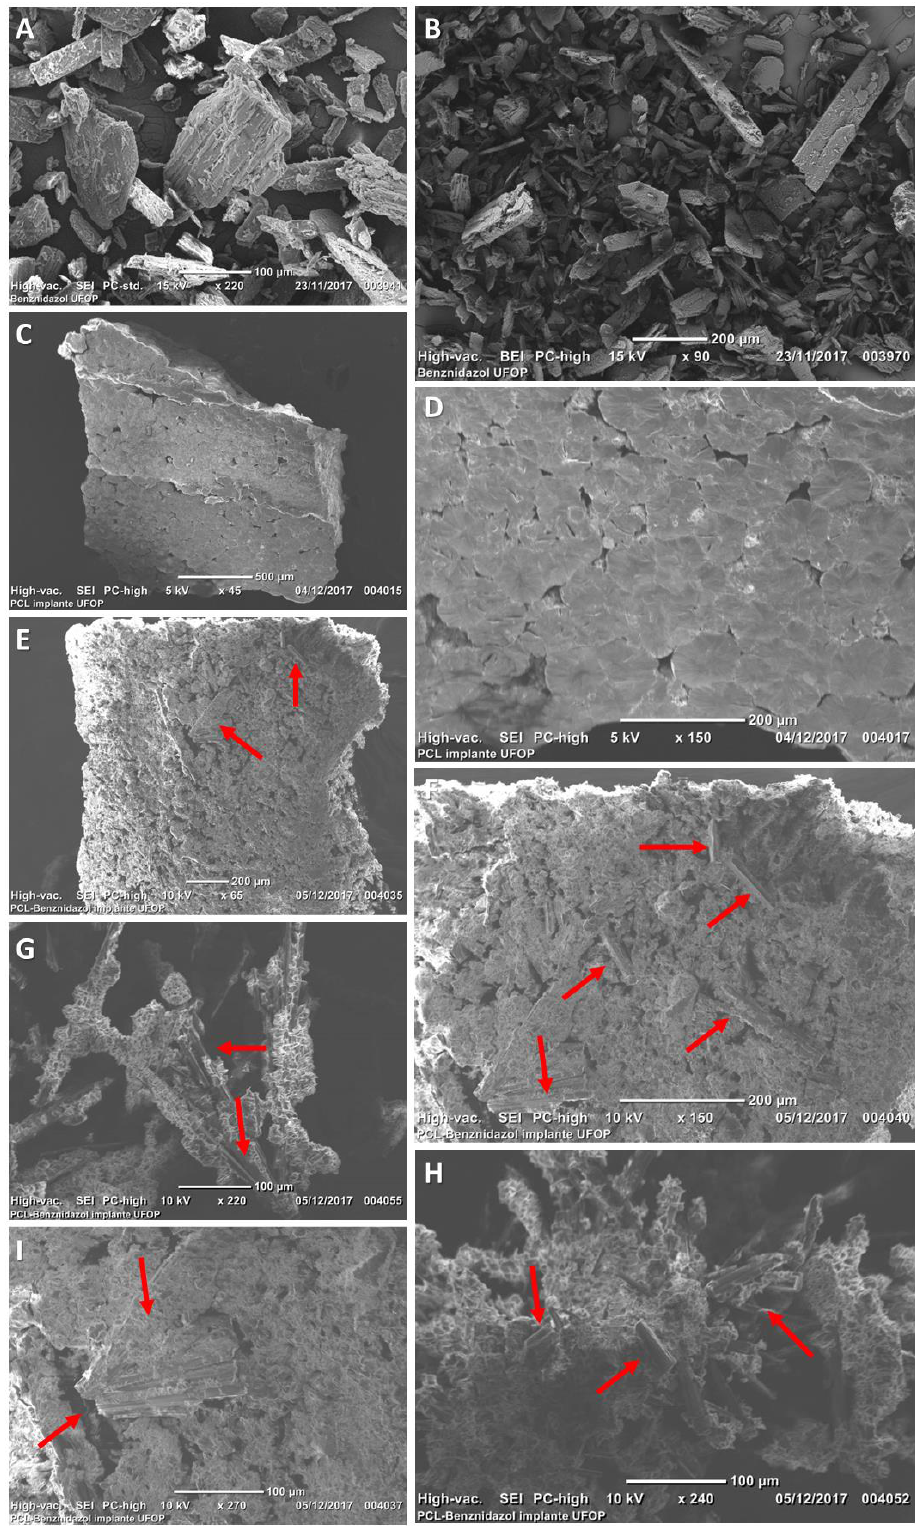
Figure 3. Scanning electron microphotographs of benznidazole: ( A ) 90 × magnification; ( B ) magnifi- cation of 220 × . PCL implants without drug: ( C ) 45 × magnification; ( D ) 150 × magnification. BZ–PCL implants at magnifications: ( E ) 65 × ; ( F ) 150 × ; ( G ) 220 × ; ( H ) 240 × ; ( I ) 270 × . The red arrows indicate BZ